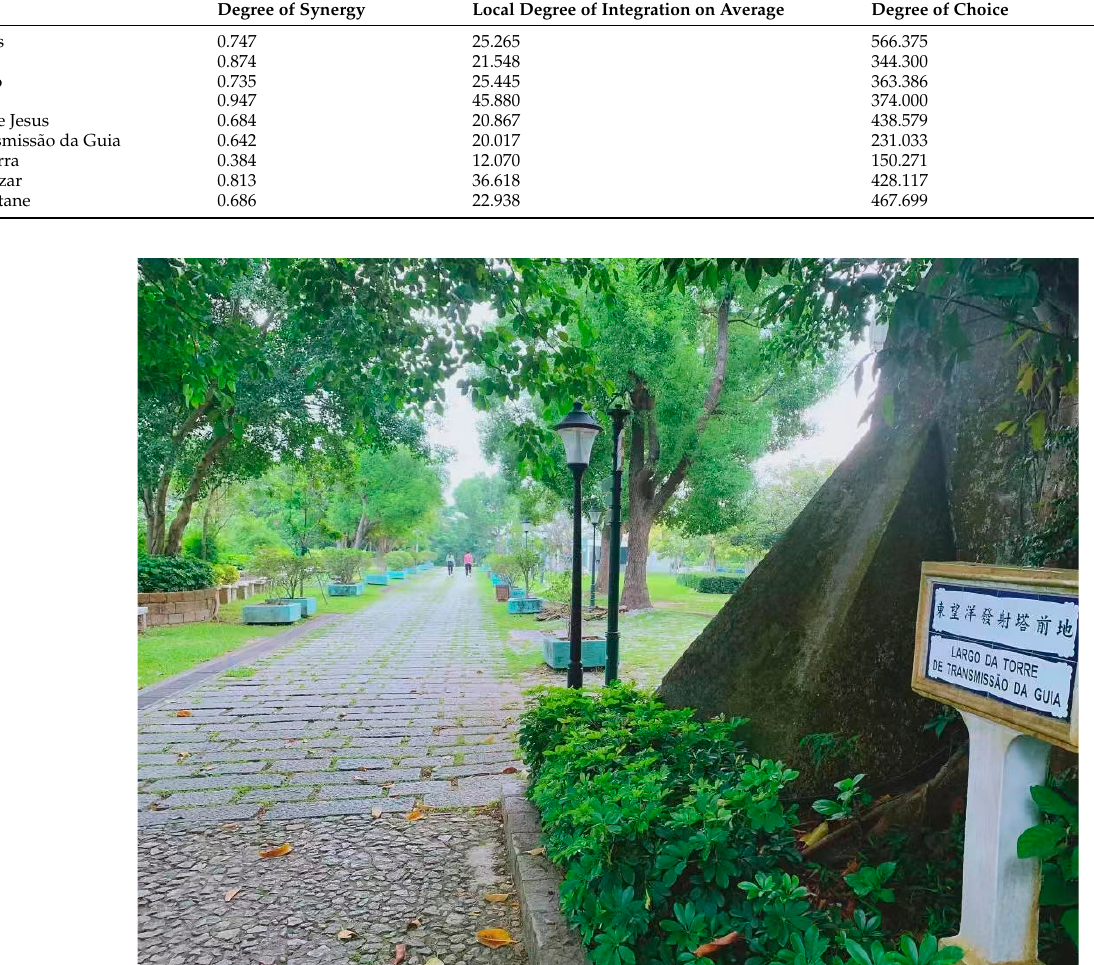
Figure 18. Guia Launch Tower Largo